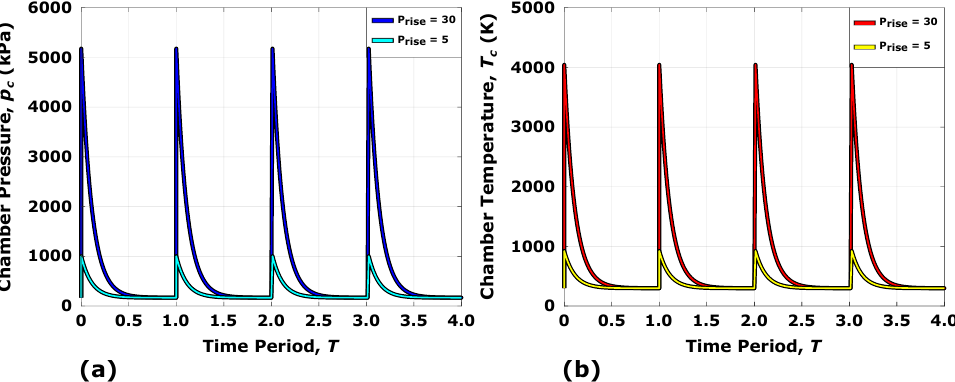
Figure 20. Synthetic data of oscillatory ( a ) pressure and ( b ) temperature for a CH 4 /O 2 detona- tion ranging from low amplitude ( p rise = 5) to the theoretical Chapman-Jouguet detonation limit ( p rise =